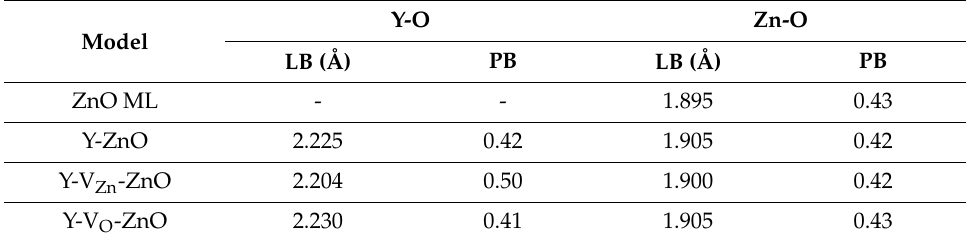
Table 3. Bond lengths (LB) and bond populations (PB) of Y-doped ZnO ML and Y-doped ZnO ML with V Zn or V O